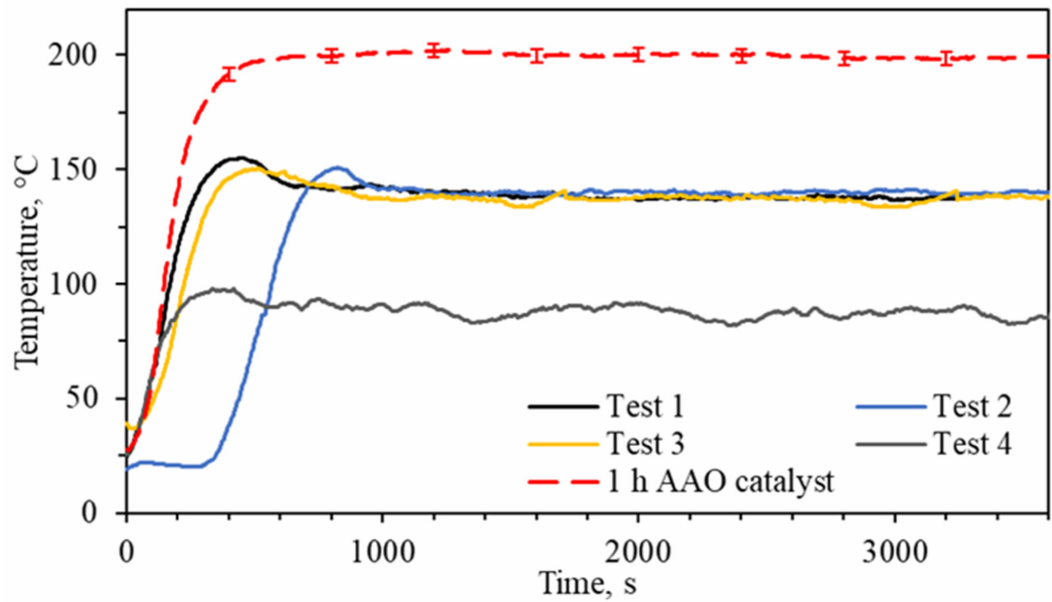
Figure 6. Combustion temperature profiles of Pt/AAO catalysts prepared using AAO supports anodized for 1 h and 4 h for 1 h of